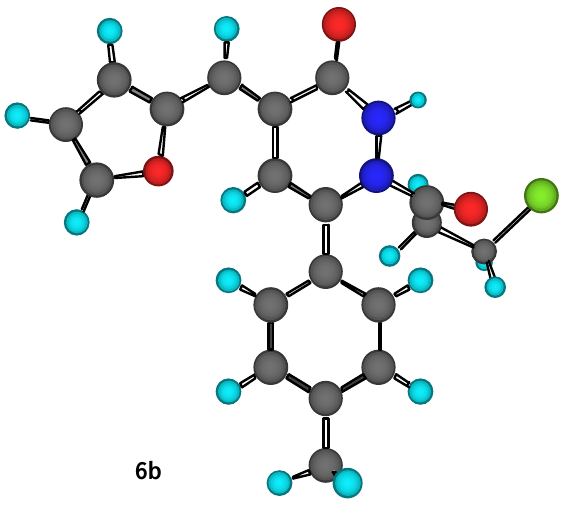
Figure 1. MM2 Calculations for compound 6b